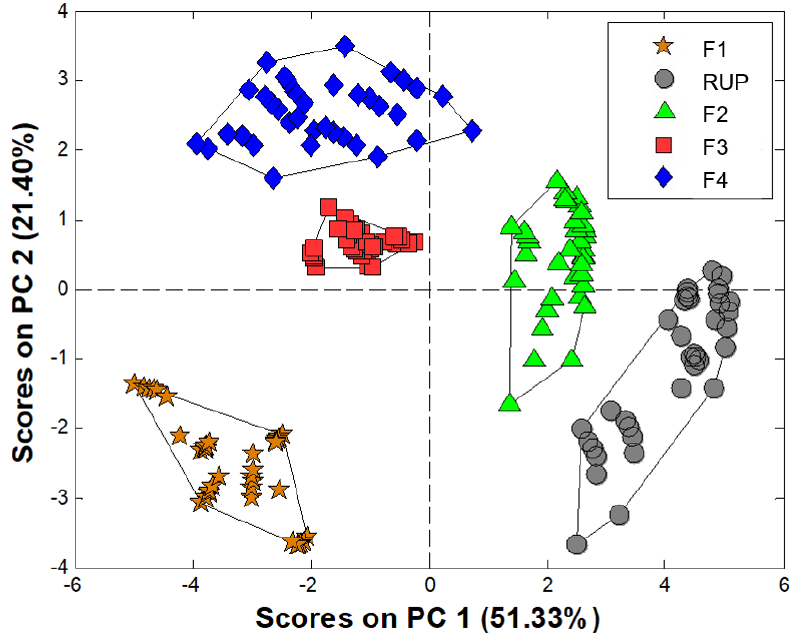
Figure 4. PCA score plot of electronic tongue results for the studied formulations (F1, F2, F3, F4) and RUP. 569